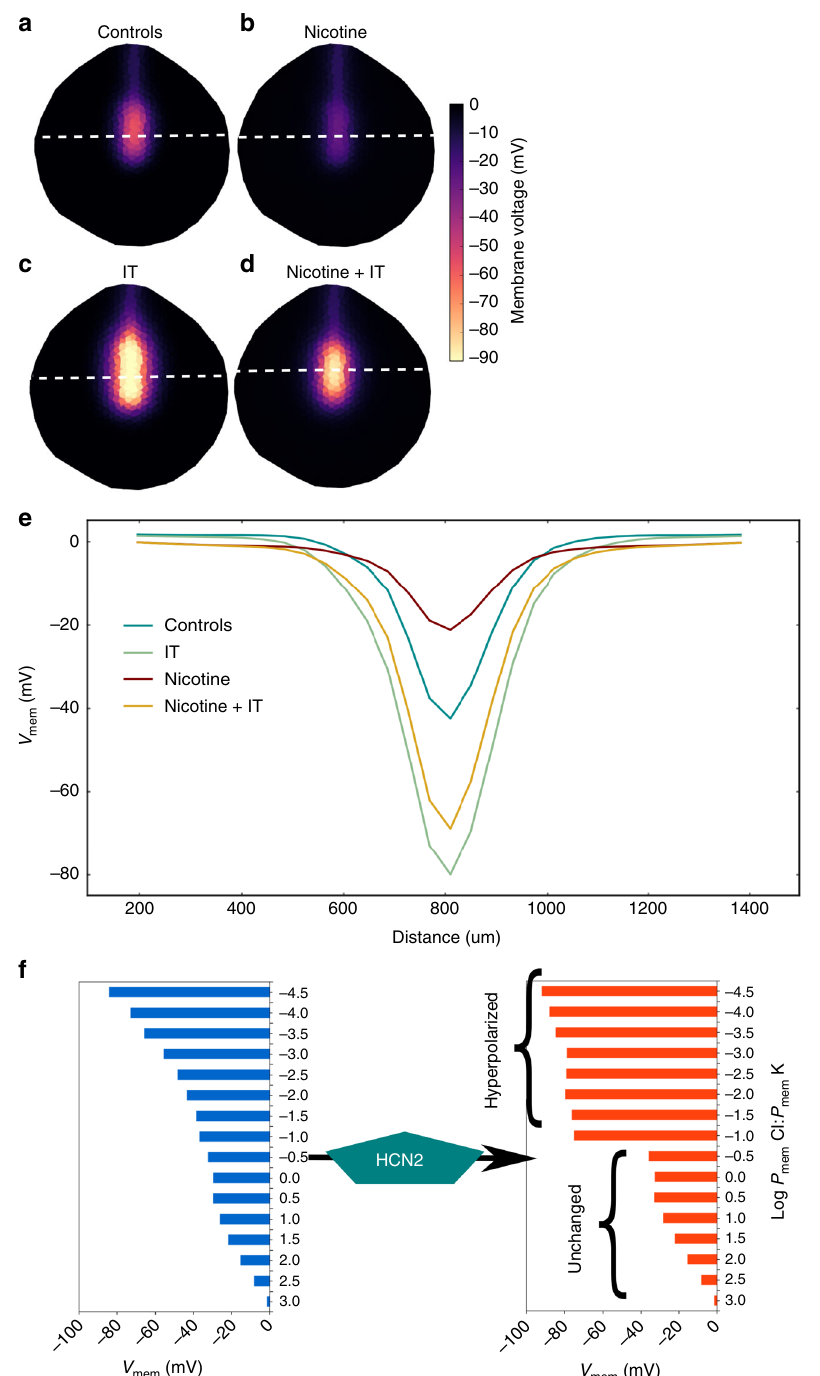
Fig. 3 BETSE model predicts that nicotine suppresses neural tube hyperpolarization and HCN2 recovers neural tube hyperpolarization in presence of nicotine. a – e BETSE model of a stage 15 Xenopus embryo where cells are assumed to be facing 0.1 × MMR. a Control model exhibits a characteristic V mem pattern featuring relative hyperpolarization in the neural tube area and depolarization everywhere else. This V mem pattern is actually seen in the Xenopus embryos with voltage reporter dyes 28 . b Nicotine treatment of the control model is predicted to preferentially depolarize the neural tube area to suppress the V mem gradient. c Model with ion translocator (IT) expression in all cells, acting in a context-speci fi c manner showing strongly enhanced neural tube V mem pattern. d Adding the ion translocator (IT) to the nicotine treated model shows the V mem pattern signi fi cantly retained in comparison to the only nicotine treated model of b . e Line graph showing the information retrieved along the white dotted lines depicted in ( a – d ), which allows for easy comparison between models. f The effect of the HCN2 channel on the V mem of a series of cells with different membrane leak permeabilities ( P mem ). The ability of homogeneously expressed HCN2 channels to act in a context speci fi c manner is predicted to stem from the channels ’ s opening at hyperpolarized V mem with a hyperpolarizing effect upon opening. This selectively hyperpolarizes cells while leaving relatively more depolarized cell ’ s V mem unchanged. This further emphasizes that HCN2 channels amplify the endogenous V mem pattern of the neural tube and maintain the V mem pattern against nicotine depolarization exactly like IT in ( c , d and e